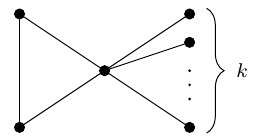
Figure 2: The graph C